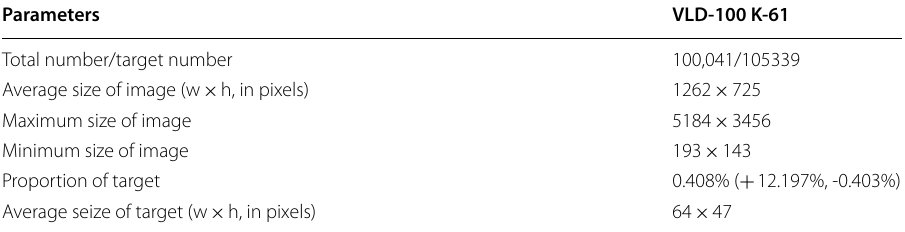
Table 2 The detail statistics of vld100k-61 Parameters